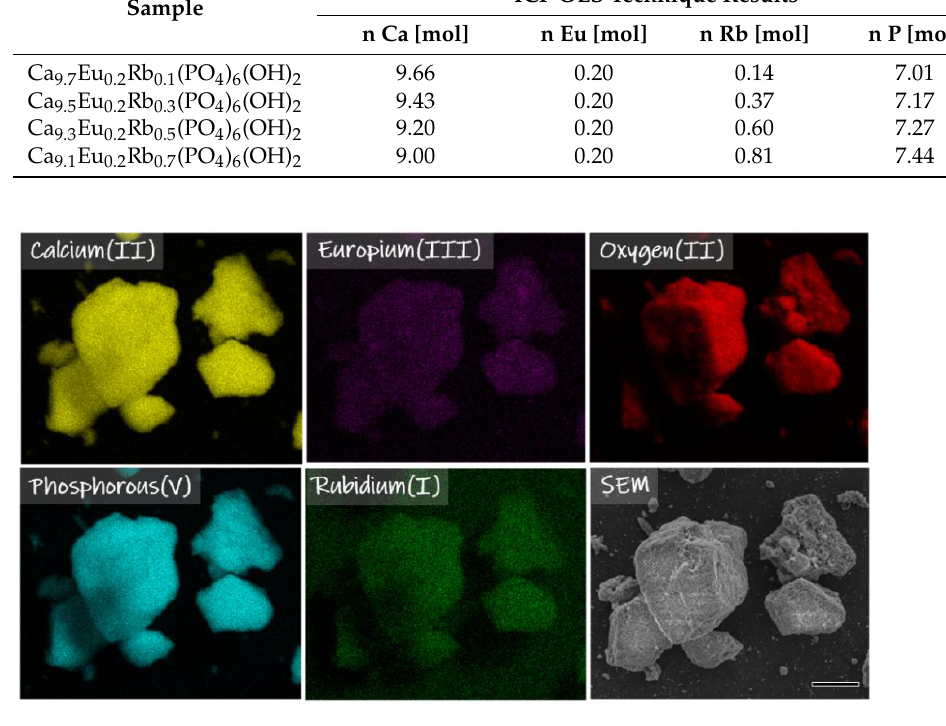
Table 1. The elemental contents in the selected nanomaterial samples of Ca 10 − (0.2 + x) Eu 0.2 Rb x (PO 4 ) 6 (OH) 2 , where x = 1, 3, 5, 7) based on ICP-OES measurements. ICP OES Technique Results Sample n Ca [mol] n Eu [mol]